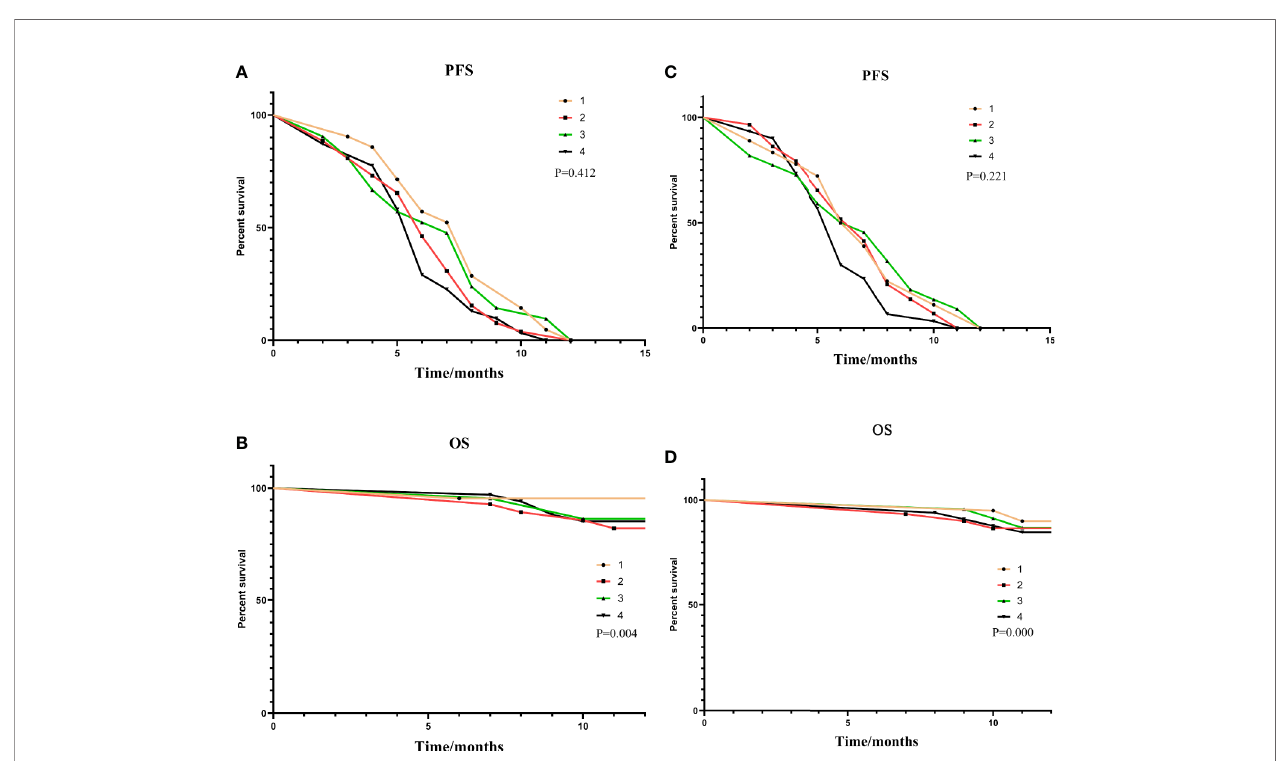
FIGURE 3 | (A, B) were subgroup analyses of HMGB1 expression before TACE, and (C, D) were subgroup analyses based on HMGB1 changes after TACE. In (A, B) : Group1: low pre-expression of HMGB1 with c-TACE; Group2: high pre-expression of HMGB1 with c-TACE; Group3: low pre-expression of HMGB1 with DEB-TACE; Group4: high pre-expression of HMGB1 with DEB-TACE. In (C, D) :Group1: low post-expression of HMGB1 with c-TACE; Group2: high post- expressions of HMGB1 with c-TACE; Group3: low post-expressions of HMGB1 with DEB-TACE; Group4: high post-expression of HMGB1 with